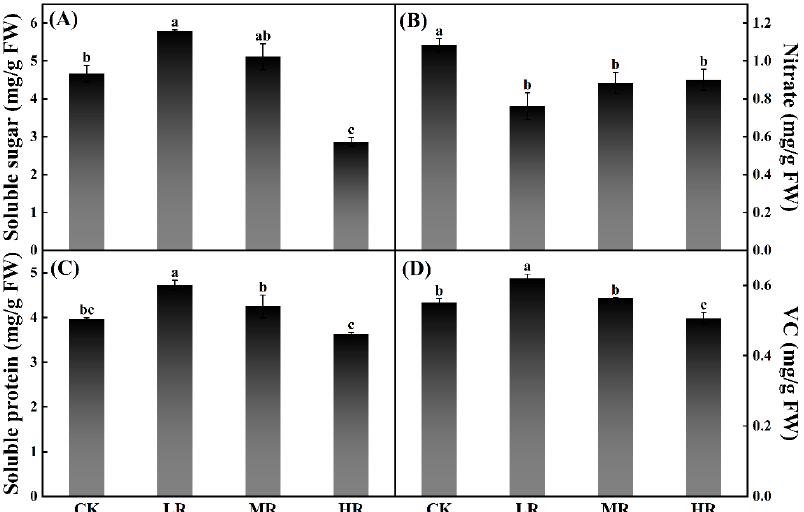
Figure 4. CK: only white light, LR: red:white = 1:2, MR = red:white = 1:1, LR = red:white = 2:1. The contents of soluble sugar ( A ), nitrate ( B ), soluble protein ( C ), and vitamin C (VC) ( D ) of pak choi grown under the different ratios of red and white light treatments. All values are expressed as mean ± standard error ( n = 3). The letters marked in all figures indicate the significance of the difference ( p ≤ 0.05, Duncan’s test).